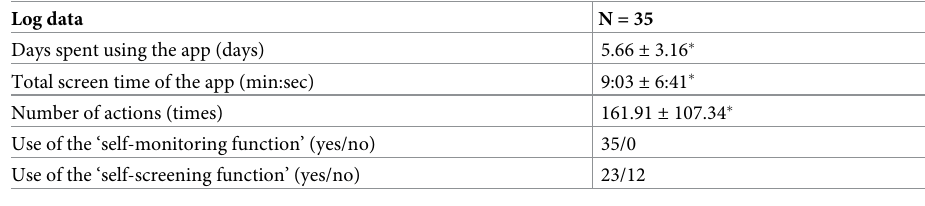
Table 2. Summary of log data.